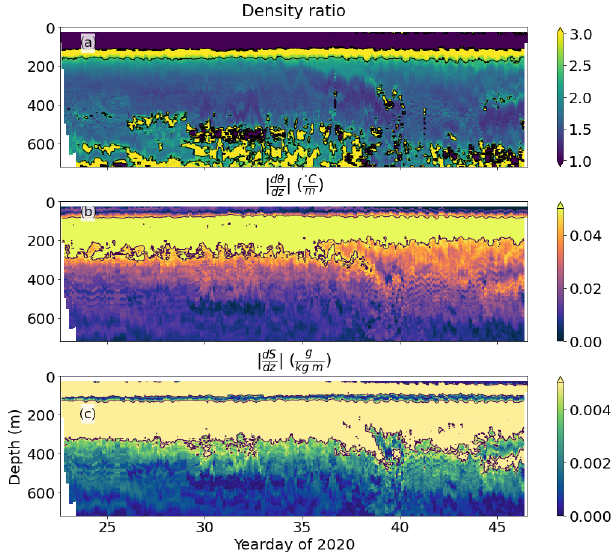
Figure 10. Key variables for the formation of thermohaline stair- cases, calculated from SG637 profiles. (a) Density ratio; (b) abso- lute vertical temperature gradient; (c) absolute vertical salinity gra- dient. Glider data from the tropical North Atlantic.